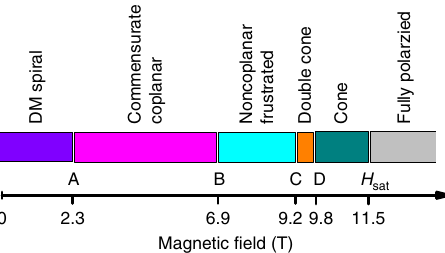
Fig. 4 The proposed phase diagram of Cs 2 CuCl 4 under pressure 1.8 GPa (which corresponds to J ′ / J =